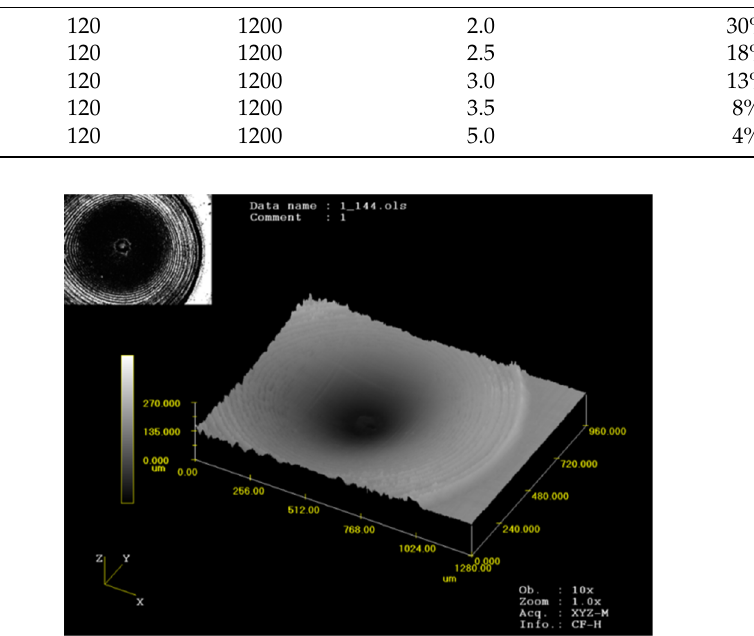
Figure 2. The stereoscopic profile of a single biomimetic unit. Table 1. The chemical constituents of medium-carbon steel and GCr15 were analyzed by EDS.